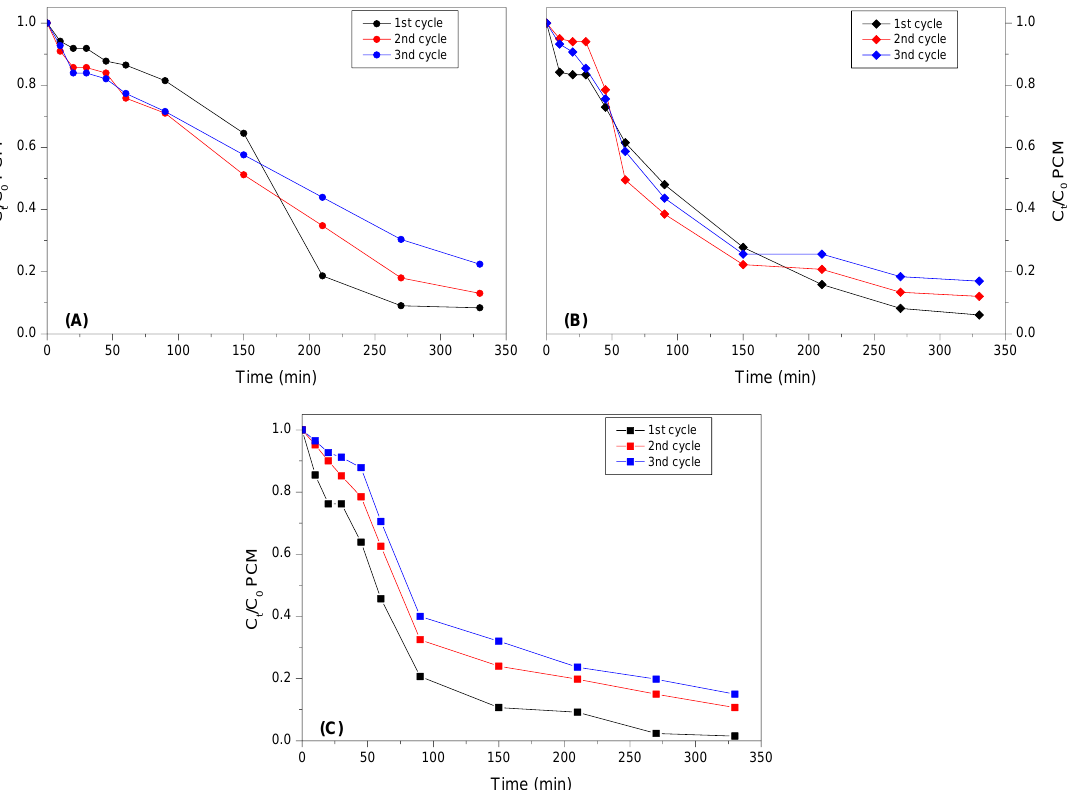
Figure 9. Recyclability of catalysts for the degradation of paracetamol (PCM). ( A ): Fe 100 / CNT; ( B ): Cu 100 / CNT and ( C ): Fe 25 Cu 75 /CNT.